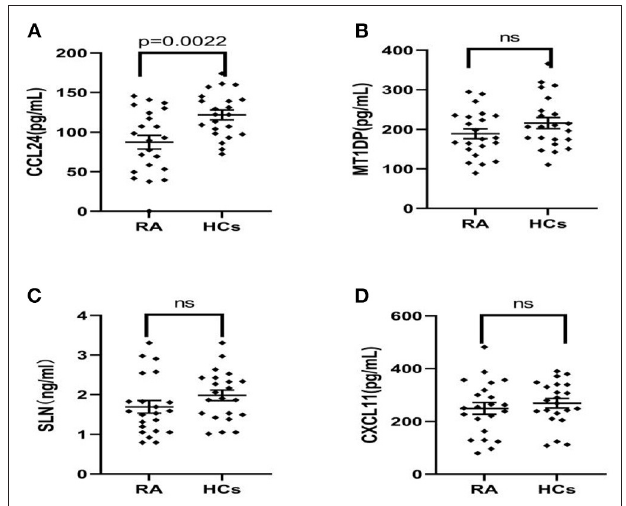
FIGURE 2 | (A–D) ELISA results of CCL24, MT1DP, SLN, and CXCL11 in the serum of RA patients ( n = 22) and health controls ( n = 22), indicated the CCL24 level has a significantly decreased expression in the RA serum and other biomarkers had not a difference. Plots indicate individual protein level of each group. Data are presented as mean ± SEM. ns, no significant.